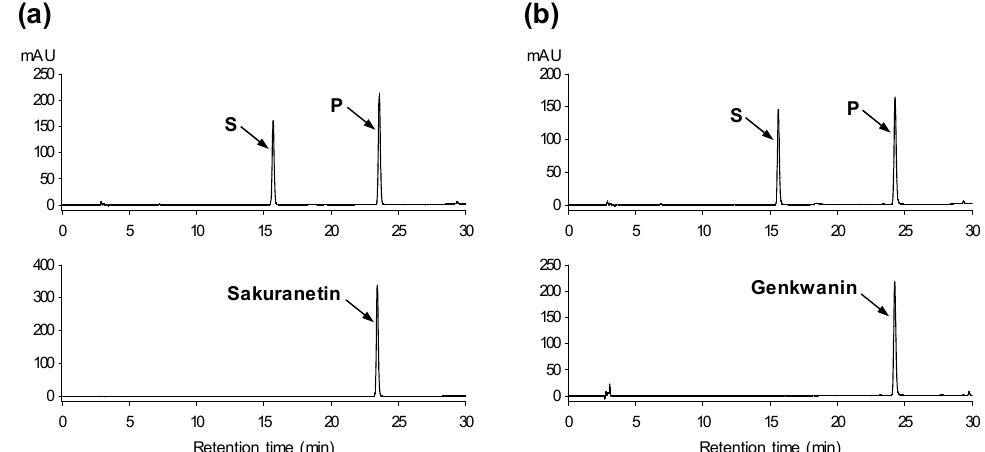
Figure 5. Representative high-performance liquid chromatography (HPLC) chromatograms of PfOMT3 reactions with flavonoid substrates. Naringenin ( a ) and apigenin ( b ) were converted to their corresponding methylated products by recombinant PfOMT3. S, substrate; P, methylated product. Upper panel: HPLC chromatograms of the PfOMT3 reaction mixtures. Lower panel: HPLC chromatograms of the authentic 7- O -methylated flavonoids, sakuranetin and genkwanin.